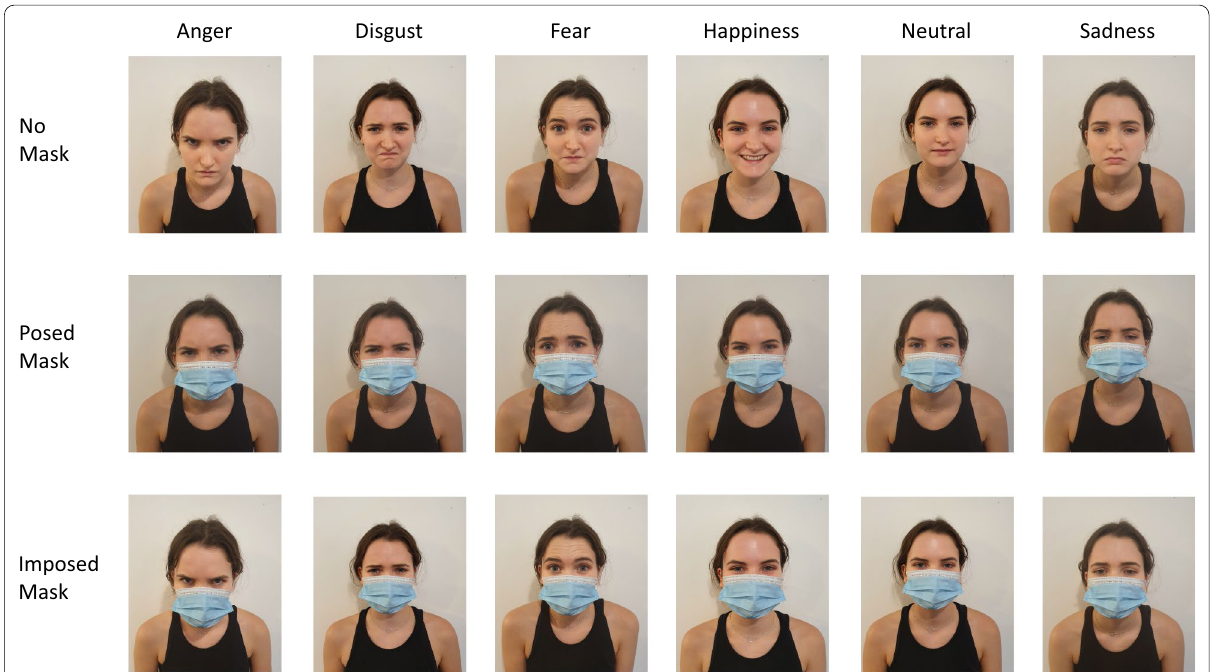
Fig. 1 Stimulus examples. Shows stimulus examples from one person in the No Mask, Posed Mask, and Imposed Mask conditions for the six different emotions tested. The Imposed Mask condition stimuli were created by graphically imposing an image of a face mask over the images from the No Mask condition, while the Posed Mask condition stimuli were taken with the person expressing the relevant emotion while wearing a